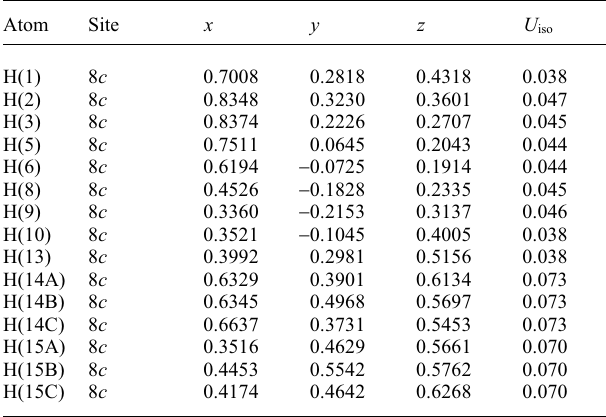
Table 2. Atomic coordinates and displacement parameters (in Å 2 )